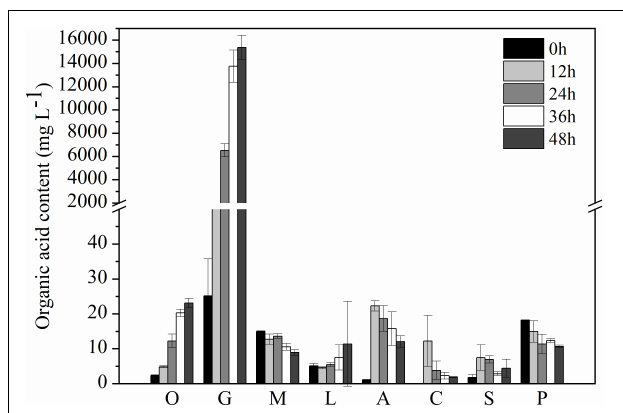
FIGURE 5 | Concentration of organic acids in the culture medium. Secreted organic acids were measured after culturing Nguyenibacter sp. L1 with AlPO 4 as the P source at 30 ◦ C for 0, 12, 24, 36, and 48 h. Vertical bars represent standard deviations of the means ( n = 3). O, oxalic acid; G, gluconic acid; M, malic acid; L, lactic acid; A, acetic acid; C, citric acid; S, succinic acid; P, propionic acid.